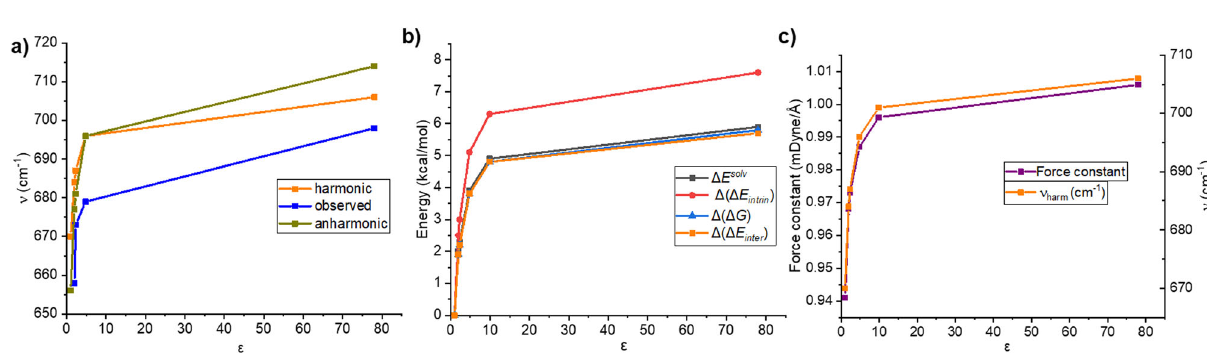
Fig. 2 The correlation between the observed and calculated properties of Me 3 NBH 3 and the solvent polarity expressed by the dielectric constant ε . a The observed and calculated an/harmonic frequencies versus ε ; b the calculated Δ ( Δ G ), Δ ( Δ E inter ), Δ ( Δ E intrin ), Δ E solv versus ε ; and c the force constant and vibration frequency of B – N stretching mode versus ε . The values are calculated at the PBE0-D3/def2-QZVP